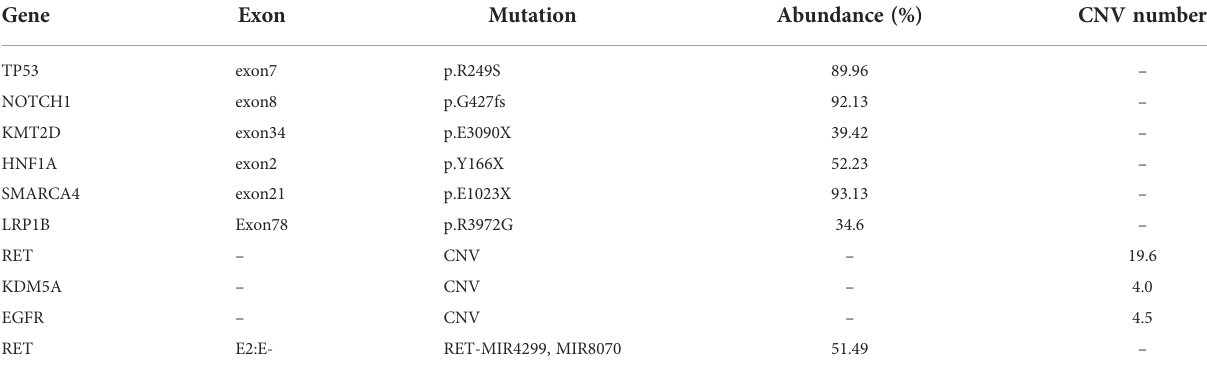
TABLE 1 Mutations detected by NGS in this